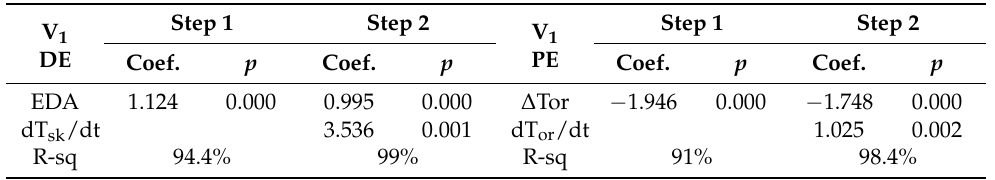
Table 5. Stepwise analysis of objective indicators and TSV.